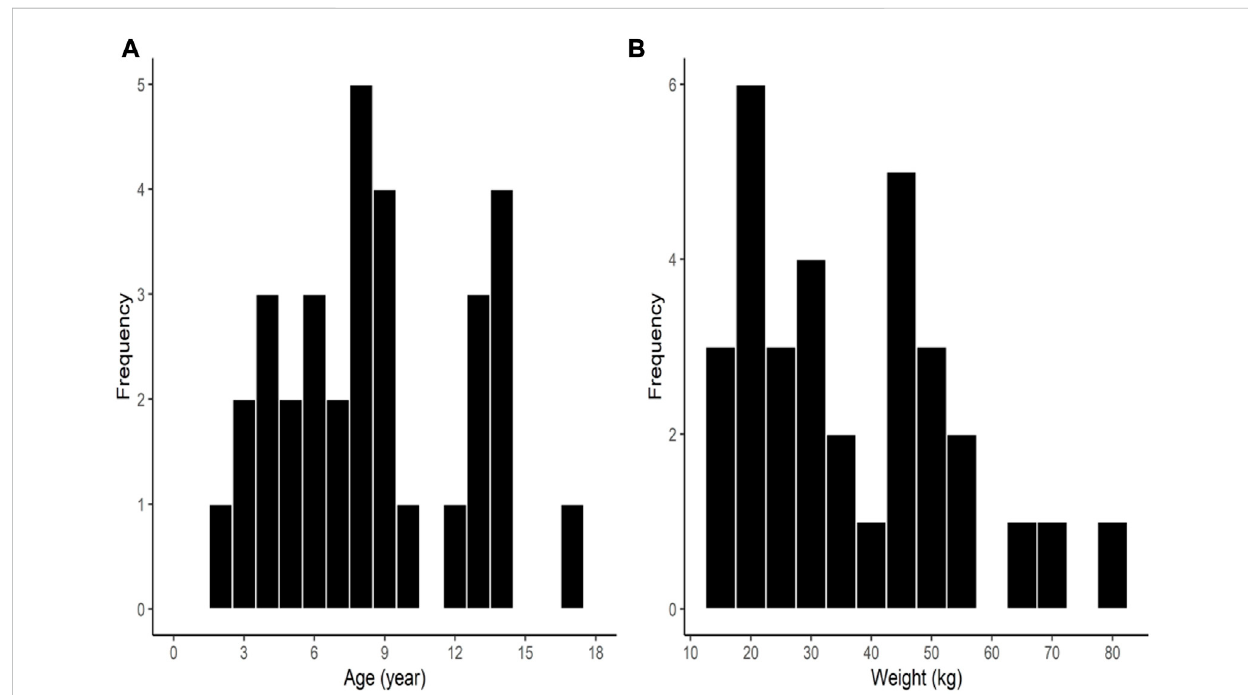
FIGURE 2 Histogram of the age (A) and body weight (B) of participants included in the